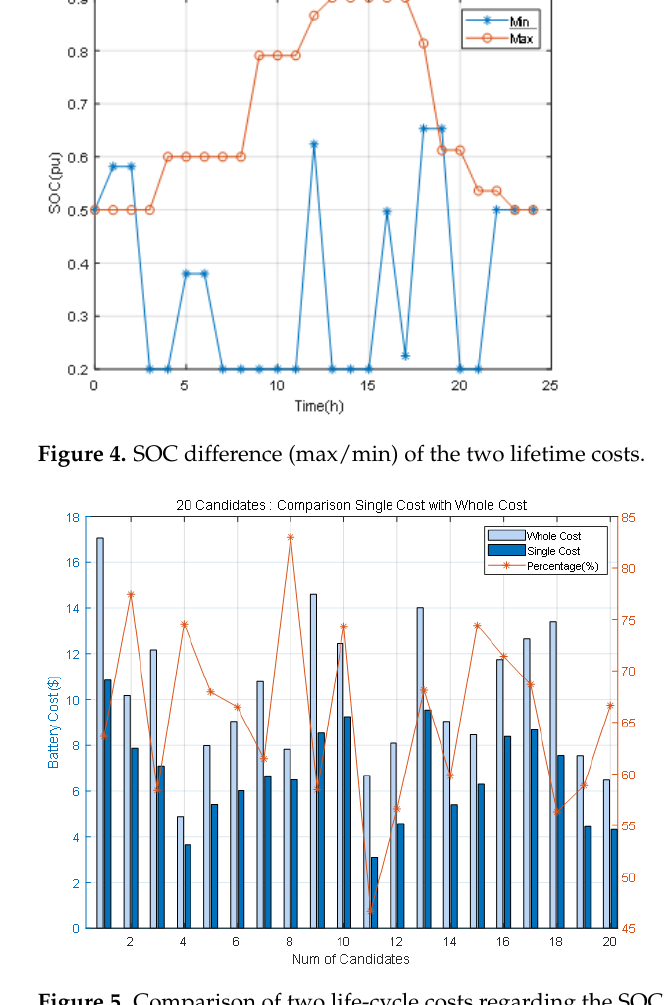
Figure 5. Comparison of two life-cycle costs regarding the SOC candidates.